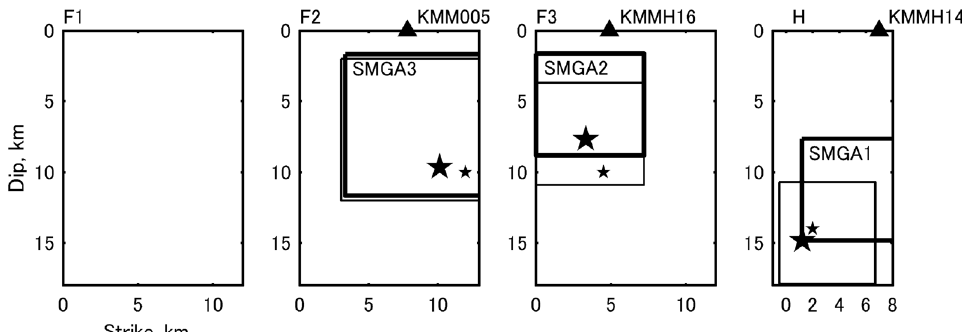
Fig. 6 Locations of SMGAs and rupture initiation points at Steps 1, 3 and 5 of the inversion procedure (GS, thin lines and small stars), and at Steps 2, 4 and 6 (SS, thick lines and large